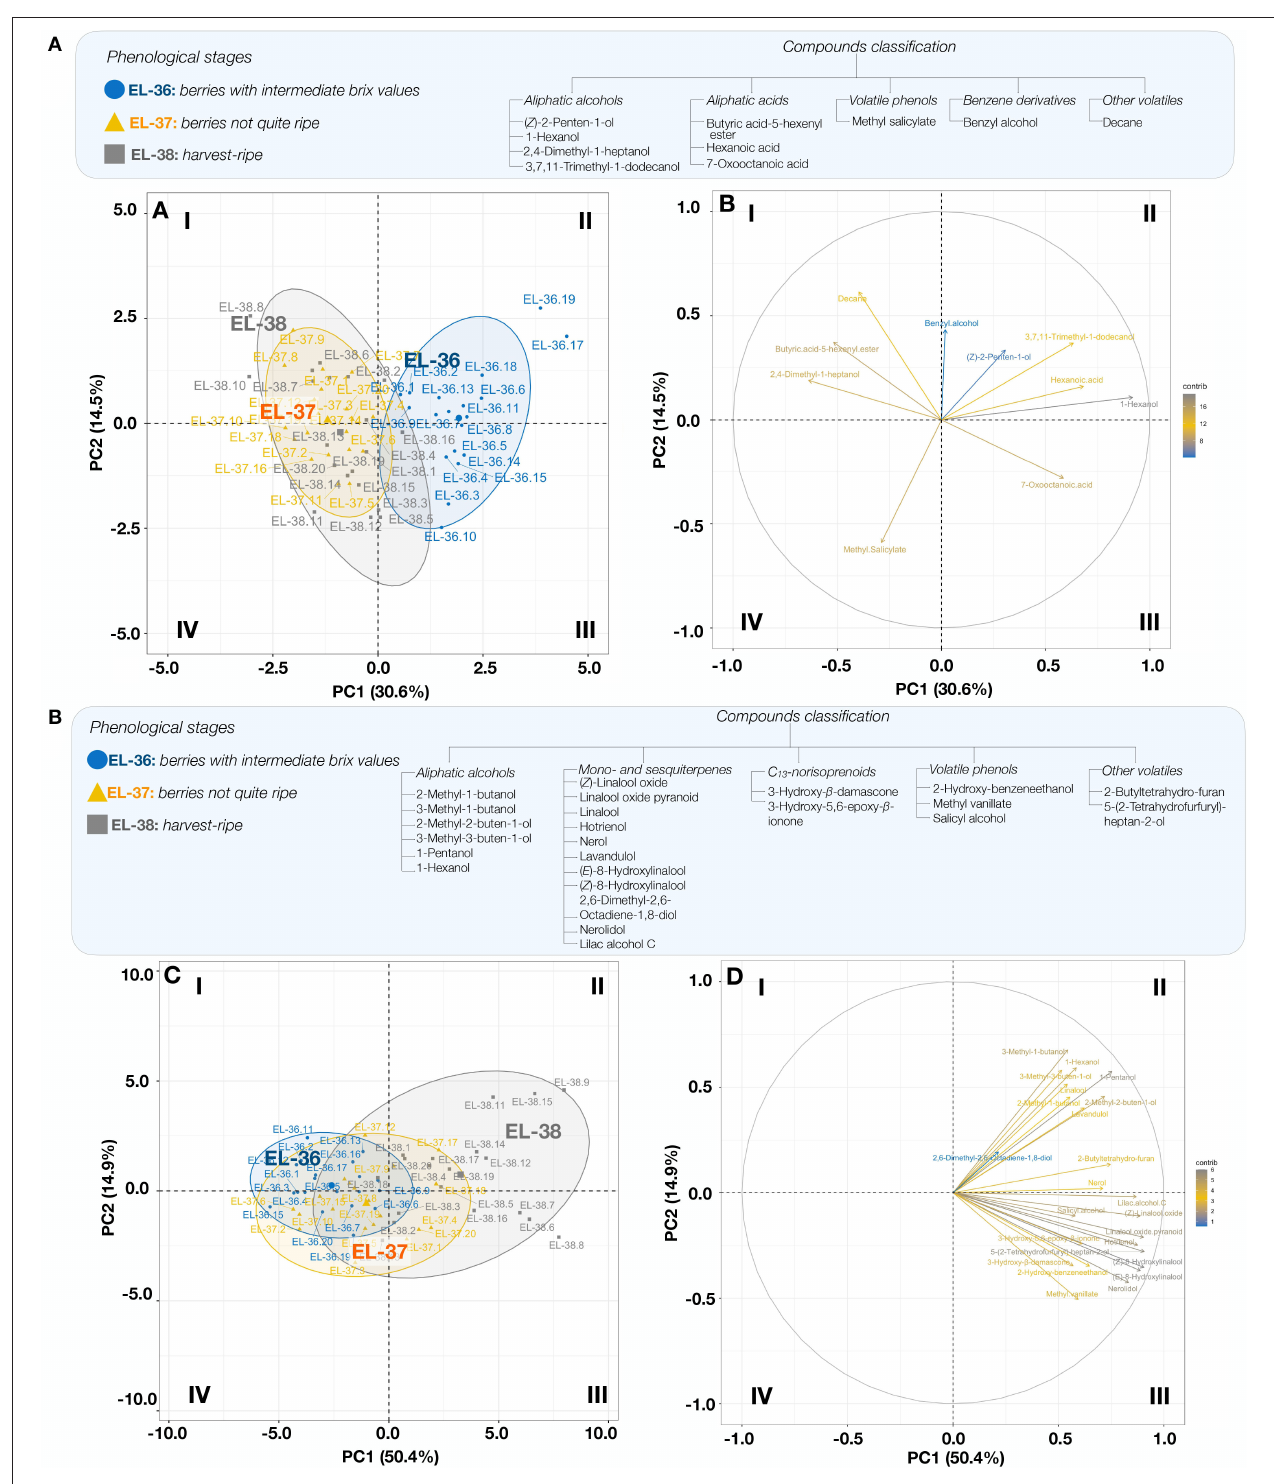
FIGURE 2 | Principal component analysis (PCA) of free volatile compounds (FVCs) (A) and glycosylated volatile compounds (GVCs) (B) (compounds; right plot) at phenological stages (EL-36, EL-37, and EL-38; samples; left plot). Biological replicates are labeled 1 to 20. FVCs include the following variables: ( Z )-2-penten-1-ol, 1-hexanol, 2,4-dimethyl-1-heptanol, 3,7,11-trimethyl-1-dodecanol, butyric acid-5-hexenyl ester, hexanoic acid, 7-oxooctanoic acid, methyl salicylate, benzyl alcohol, and decane. GVCs include the following variables : 2-methyl-1-butanol, 3-methyl-1-butanol, 2-methyl-2-buten-1-ol, 3-methyl-3-buten-1-ol, 1-pentanol, 1-hexanol, ( Z )-linalool oxide, linalool oxide pyranoid, linalool, hotrienol, nerol, lavandulol, ( E )-8-hydroxylinalool, ( Z )-8-hydroxylinalool, 2,6-dimethyl-2,6-octadiene-1,8-diol, nerolidol, lilac alcohol, 3-hydroxy- β -damascone, 3-hydroxy-5,6-epoxy- β -ionone, 2-hydroxy-benzeneethanol, methyl vanillate, salicyl alcohol, 2-butyltetrahydro-furan, and 5-(2-tetrahydrofurfuryl)-heptan-2-ol. Quadrants are identified I-IV (clockwise).